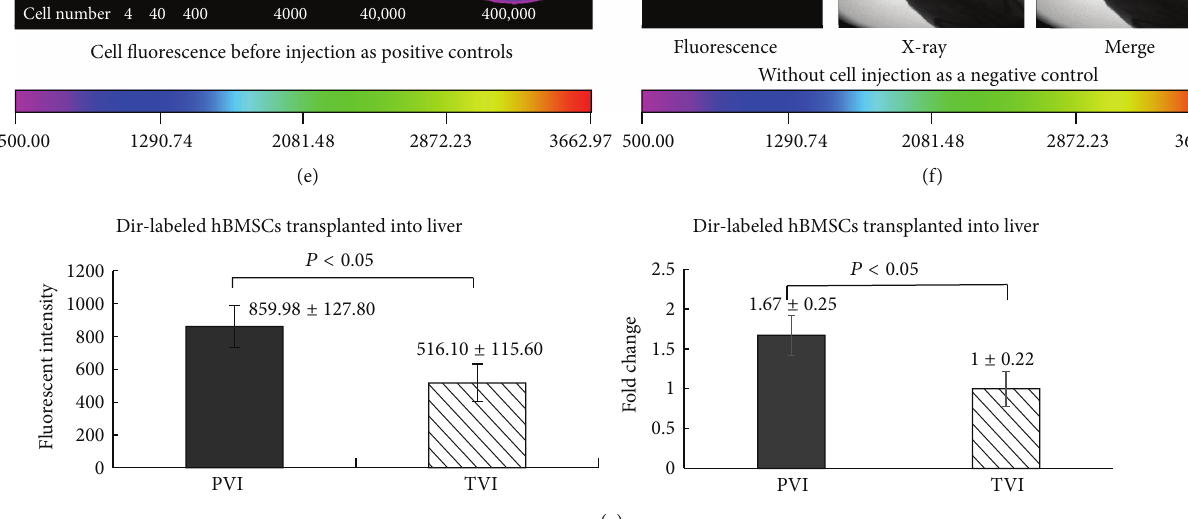
(compared with normal control, fold change: 1.56 ± 0.8